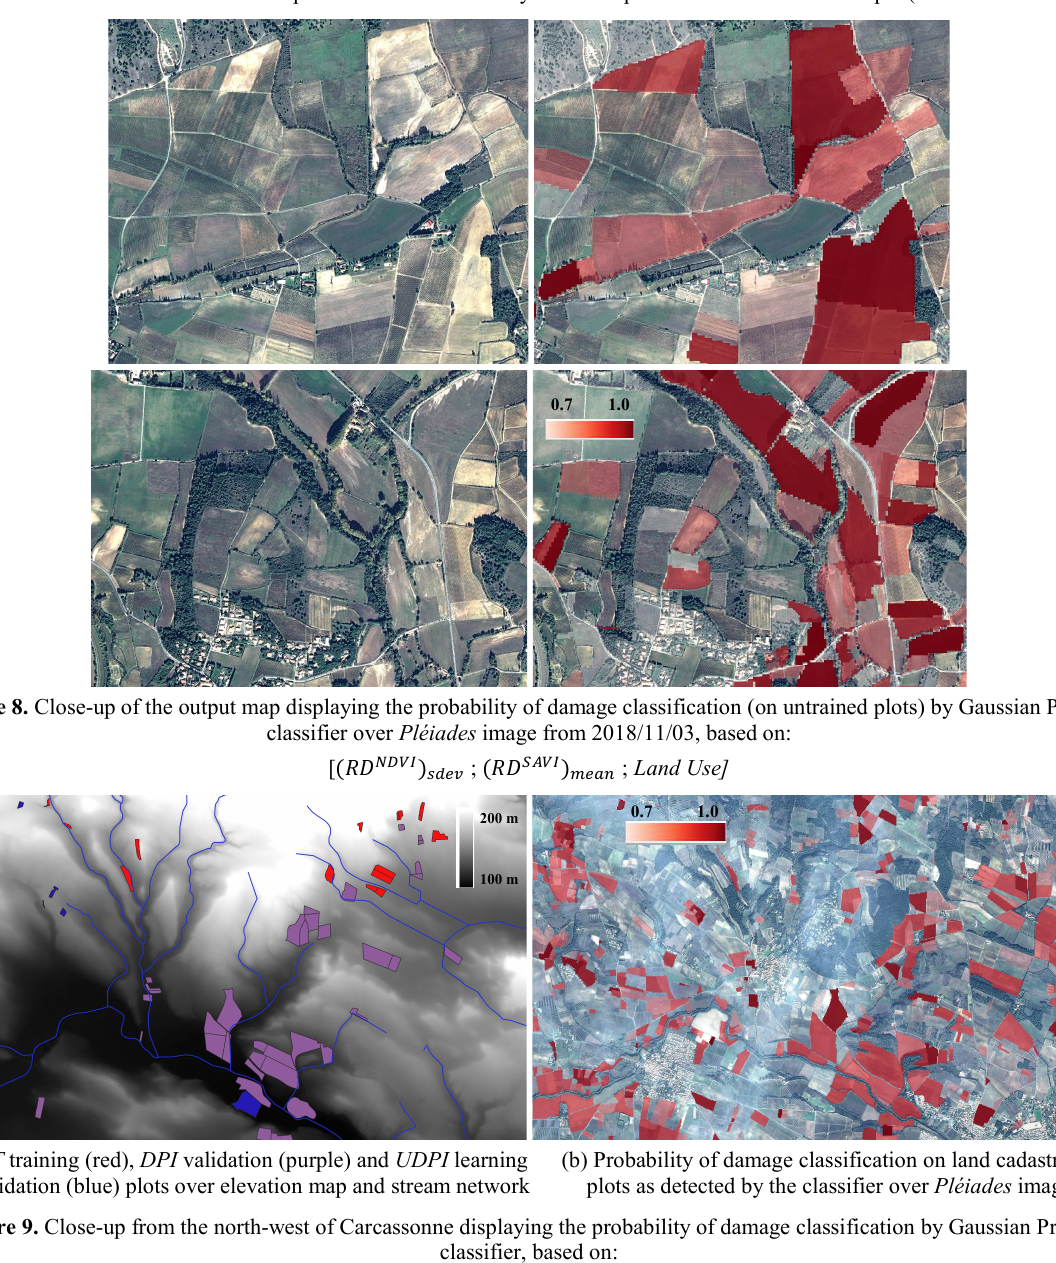
Table 5 . Best results from 3-variable supervised classifications by Gaussian process over validation sample ( UDPI *: half of UDPI ).